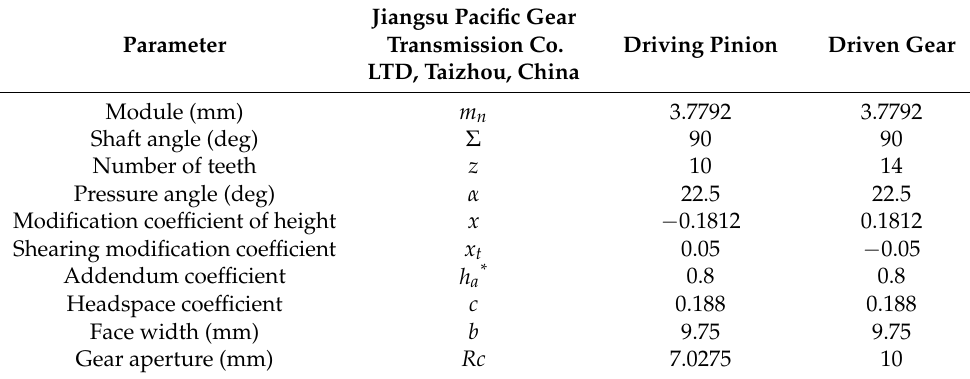
Table 1. Basic geometric data of the example straight bevel gear pair.